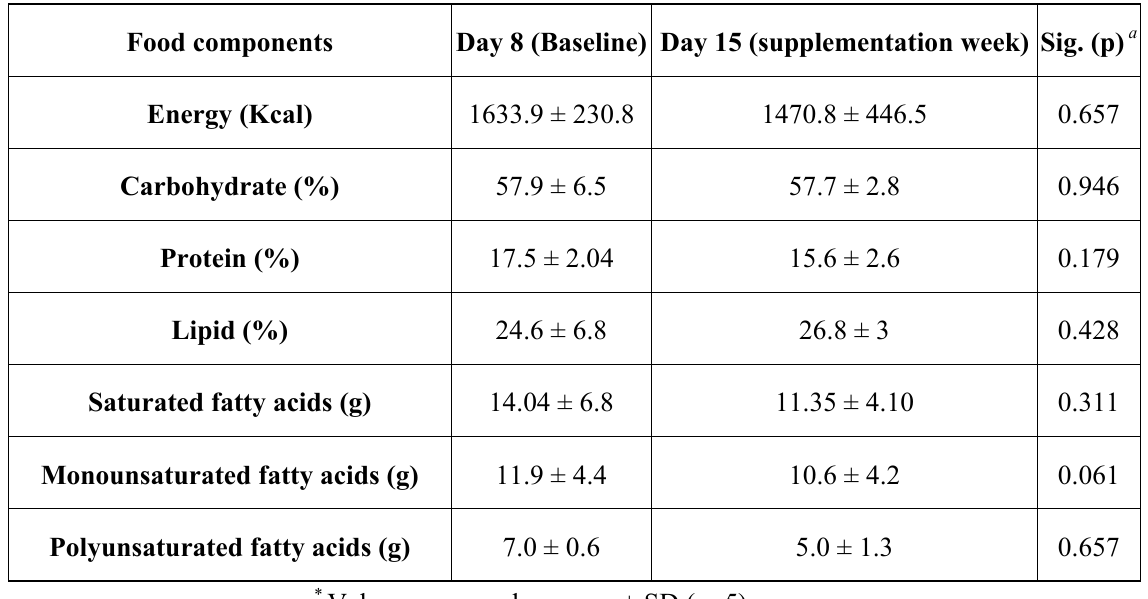
Table 3. Diet composition of the subjects in the baseline and during the supplementation week*.